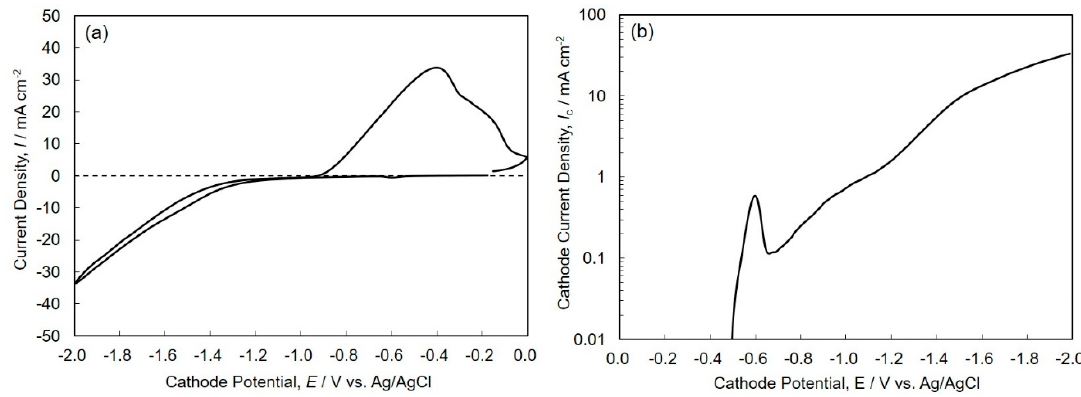
Figure 2. Cyclic voltammogram ( a ) and the Tafel plot ( b ) for electrodeposition of Sn-Zn alloys on a copper electrode.